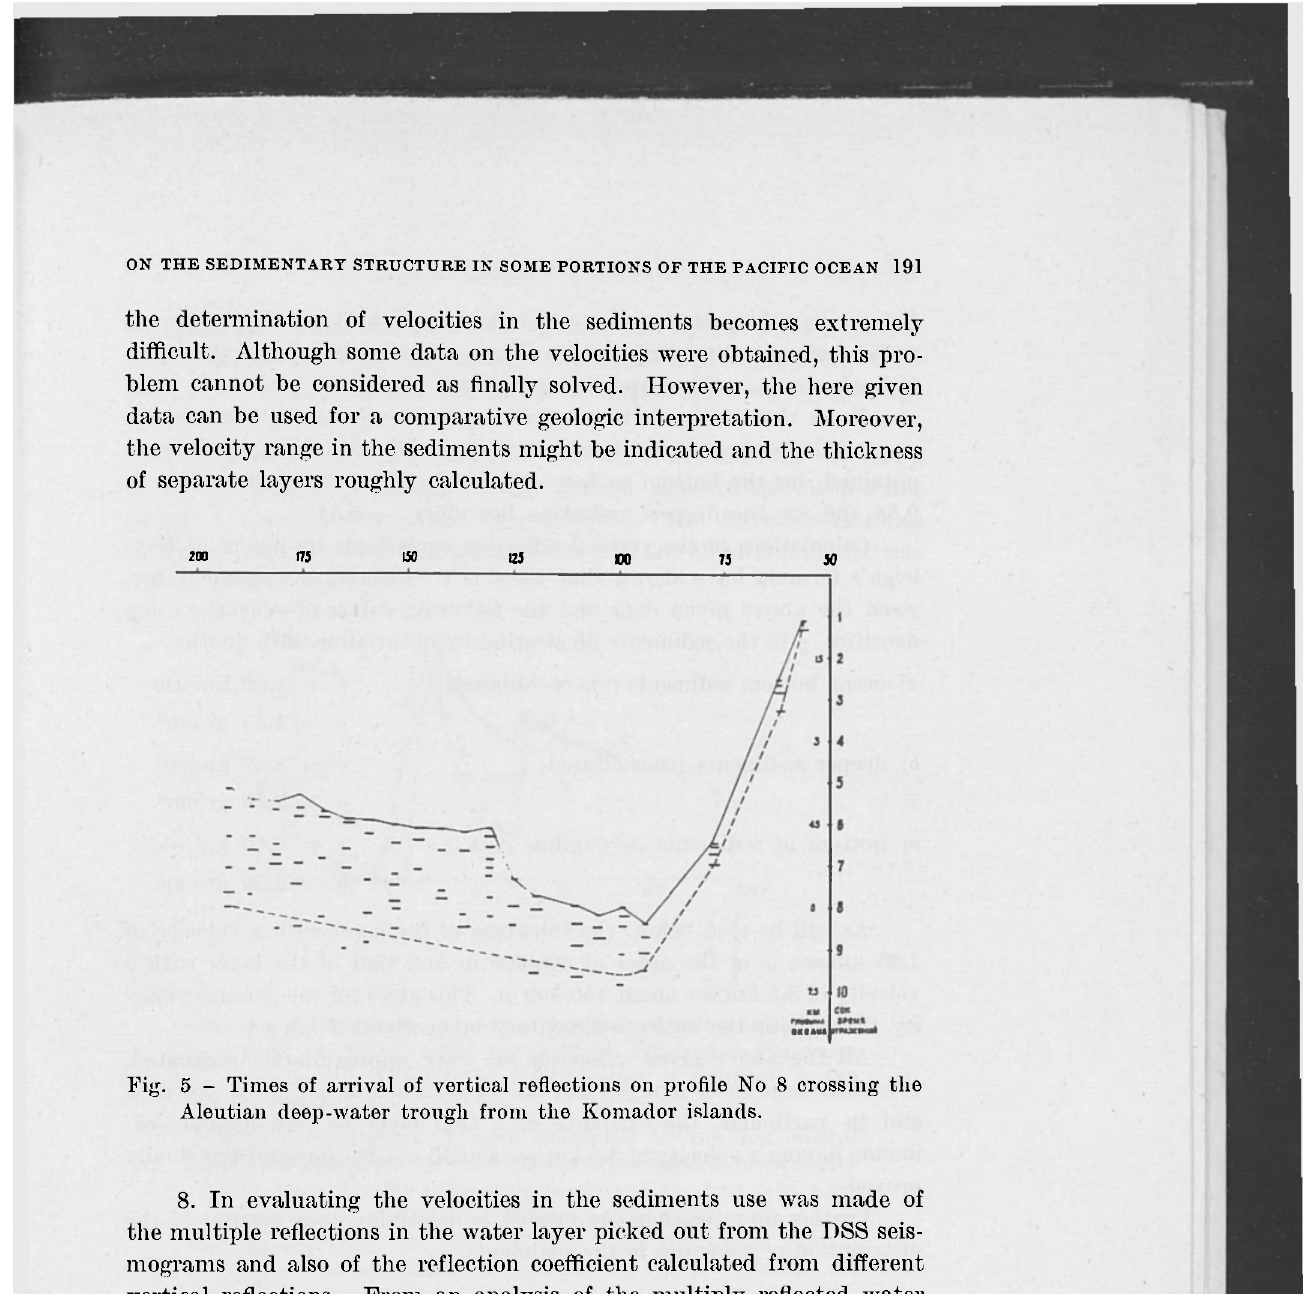
8. In evaluating the velocities in the sediments use was made of the multiple reflections in the water layer picked out from the T)SS seis- mograms and also of the reflection coefficient calculated from different vertical reflections. From an analysis of the multiply reflected water waves, including the regions of growing amplitudes connected with the critical angles ( 3 ), on one of the profiles considered below running above the ocean bed, the following values of velocities were obtained: in the subbottom layer — 1,62-1,67 km/sec (*) and in the deeper layer — 1,89-1,91 km/sec. The way in which the experimental data agree with (*) Here and below the thin layer (5-14 m thick) covering the sea bot- tom is not taken into consideration. be seen on the seismograms of fig.